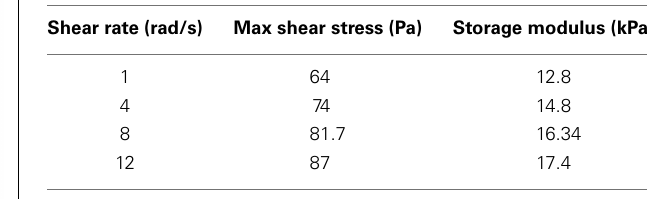
Table 4 | Storage modulus and maximum shear stress of MRE under different shear rate .